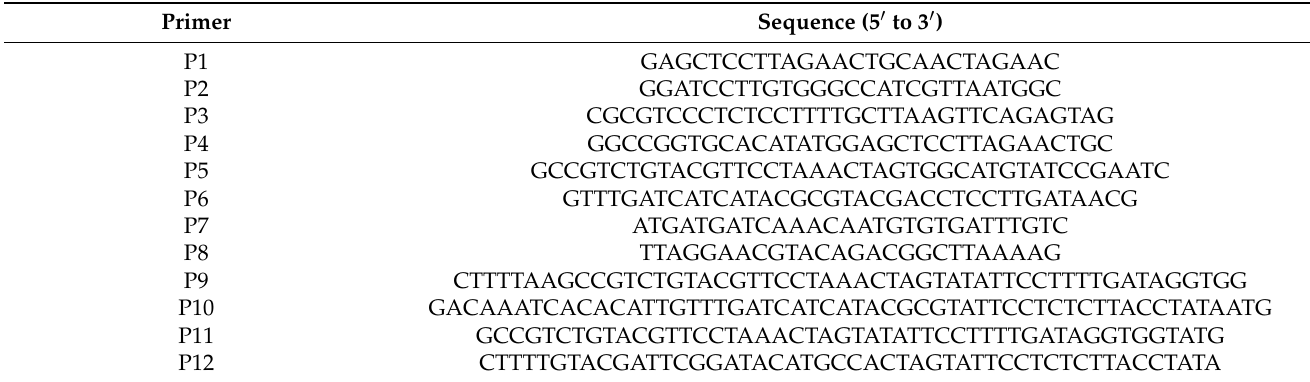
Table 2. Primers used in this